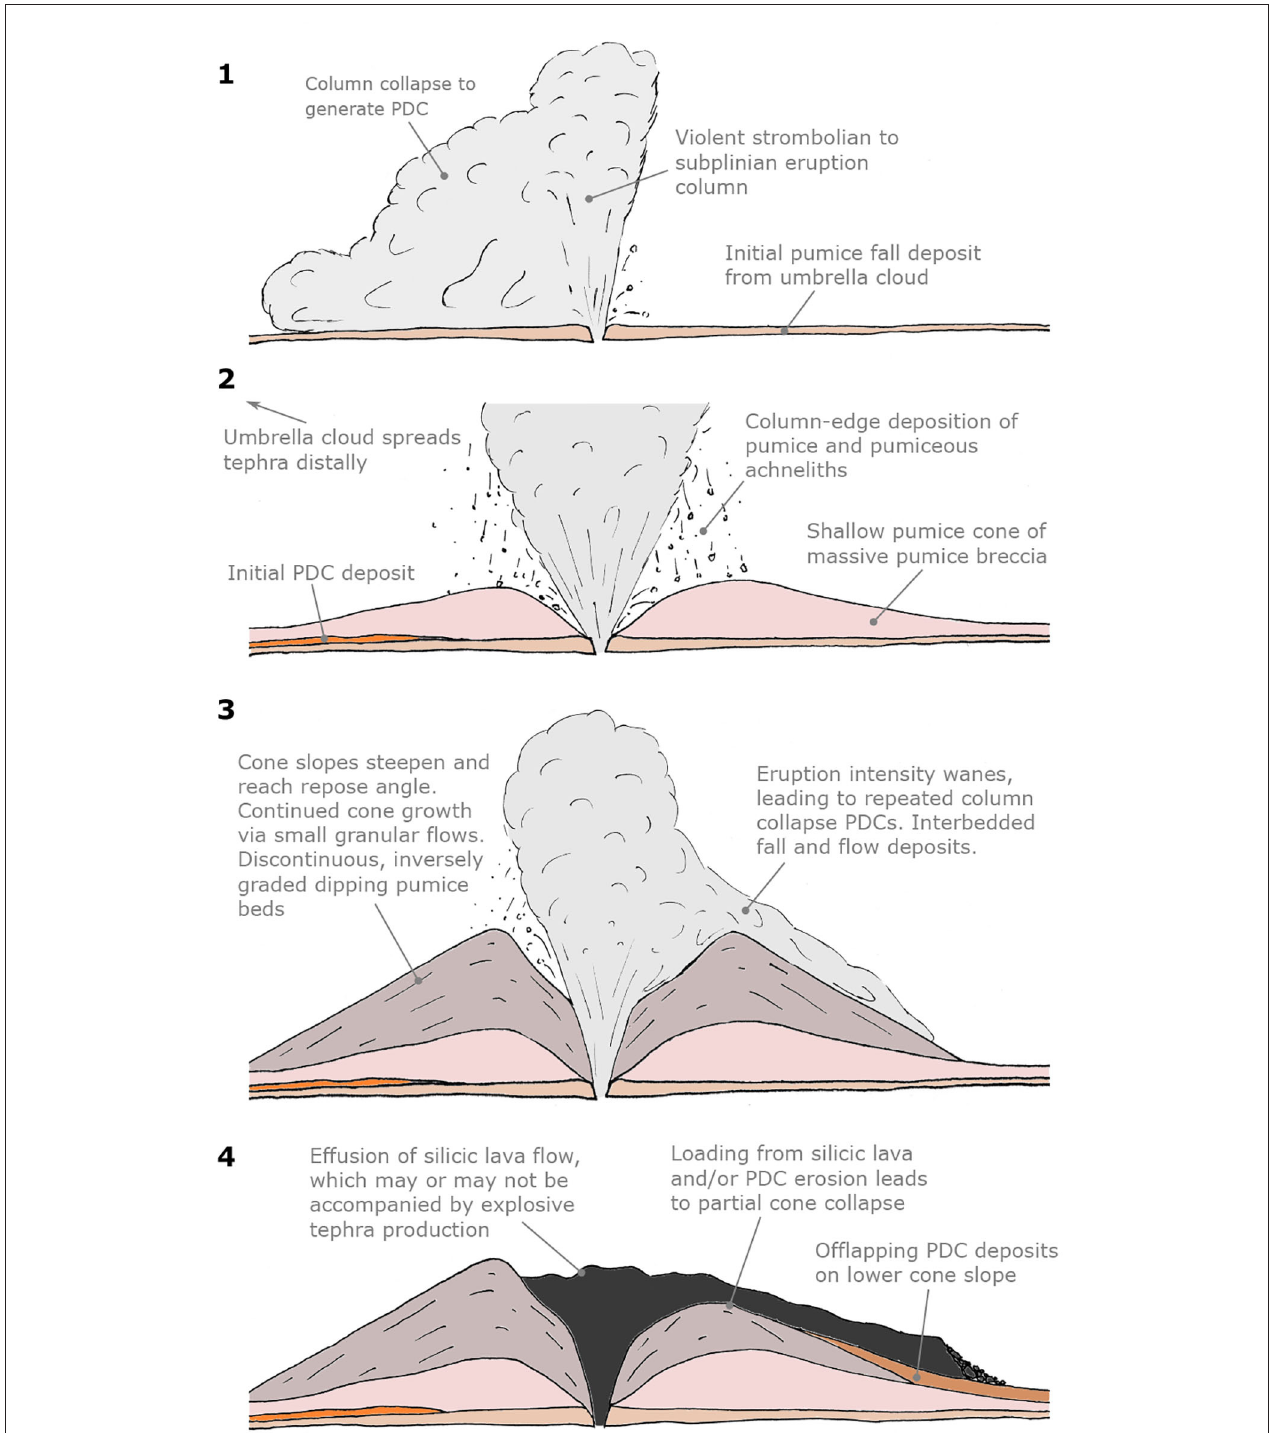
FIGURE 2 | A generalized sequence of a pumice cone eruption at Aluto constructed from the record of nine distinct, but similar, eruptions. Some eruptions begin with the generation of a convective plume producing relatively widespread tephra fall deposits that transition into PDC deposits as the column collapses. Most pumice cone forming eruptions at Aluto begin at stage 2, where a convective eruption plume is generated, and an increasingly steep-sided pumice cone is deposited around the vent from tephra falling from the column-edge, and ballistic deposition (Clarke et al., 2019; Clarke, 2020). As the eruption wanes, the column becomes unsteady, often generating multiple intercalated tephra fall and PDC deposits. The end of the eruption is marked by the emplacement of a silicic lava flow, which may or may not be accompanied by explosive tephra production. Column collapse PDCs are likely to be generated at stages 1 and 3. After Clarke (2020).